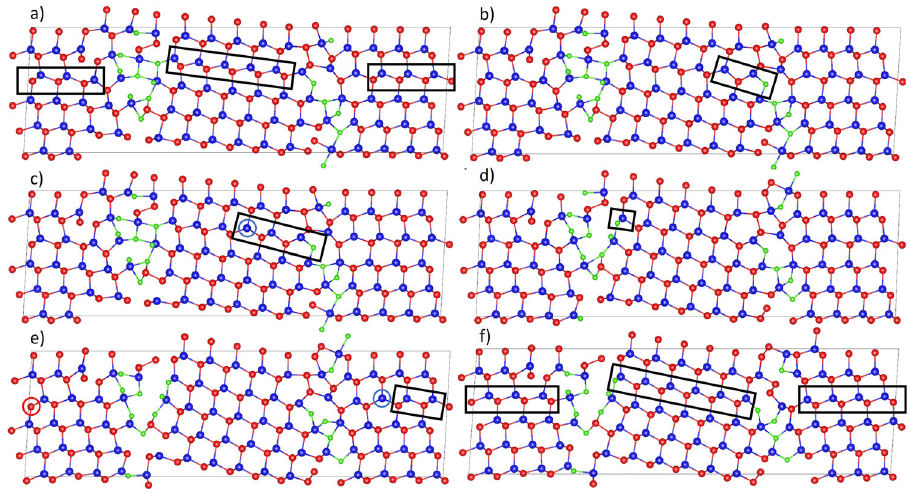
Fig. 7 Atomic mechanism of stacking fault removal with Cl saturated grain boundaries. The energy pro fi le for this mechanism is given in Fig. 6b. a (Image 0) Lowest energy stacking fault structure with 14 Cl; the stacking fault layer is indicated by the rectangles. b (Image 5) The removal is initiated by a Te atom moving to an interstitial position with a 0.6 eV barrier shown in the rectangle. c (Image 10) The Te cascade has advanced by another step into the grain interior with a 0.6 eV energy barrier. d (Image 25) The Te cascade has completed the stacking fault removal between the grain boundaries with energy barriers of ≃ 0.4 eV. e (Image 30) The remaining wrap-around stacking fault is removed in the vicinity of both grain boundary cores simultaneously with 0.6 eV barrier. f (Image 34) The stacking fault is fully removed resulting in 2.1 eV energy decrease from previous metastable state and a 1 eV energy decrease from the original faulted structure. Cd: Blue, Te: Red, Cl: